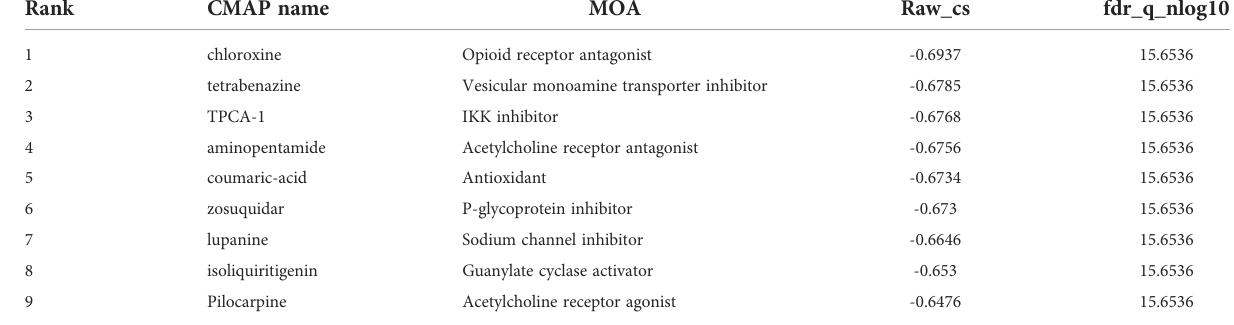
TABLE 2 Identi fi ed 9 small molecular drugs by